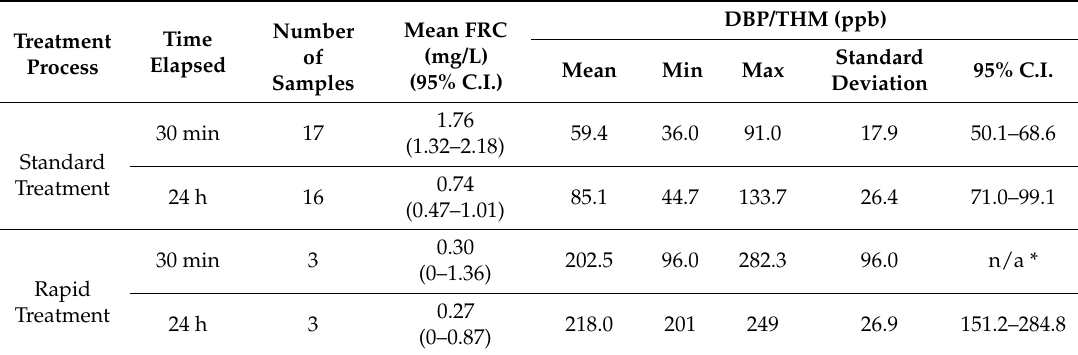
Table 4. DBP/THM levels observed at the Palorinya SWTP following standard and rapid treatment.